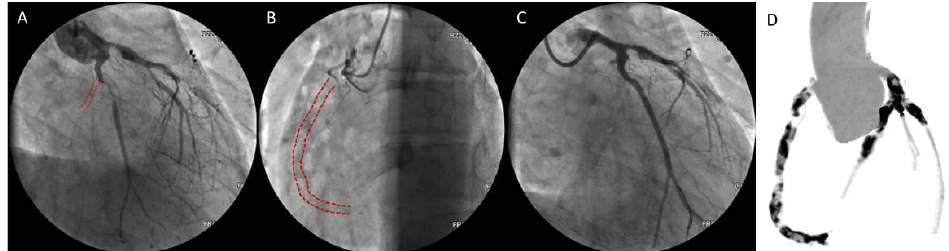
Figure 1. Coronary angiography ( A – C ) and computed tomography image ( D ) of three-vessel disease in a 22-years old patient with polyarteritis nodosa. Angiography showed chronic total occlusion of the right and circumflex coronaries. Reproduced with permission from [26] under the creative common license (http://creativecommons.org/publicdomain/zero/1.0/) (accessed on 31 May 2021).